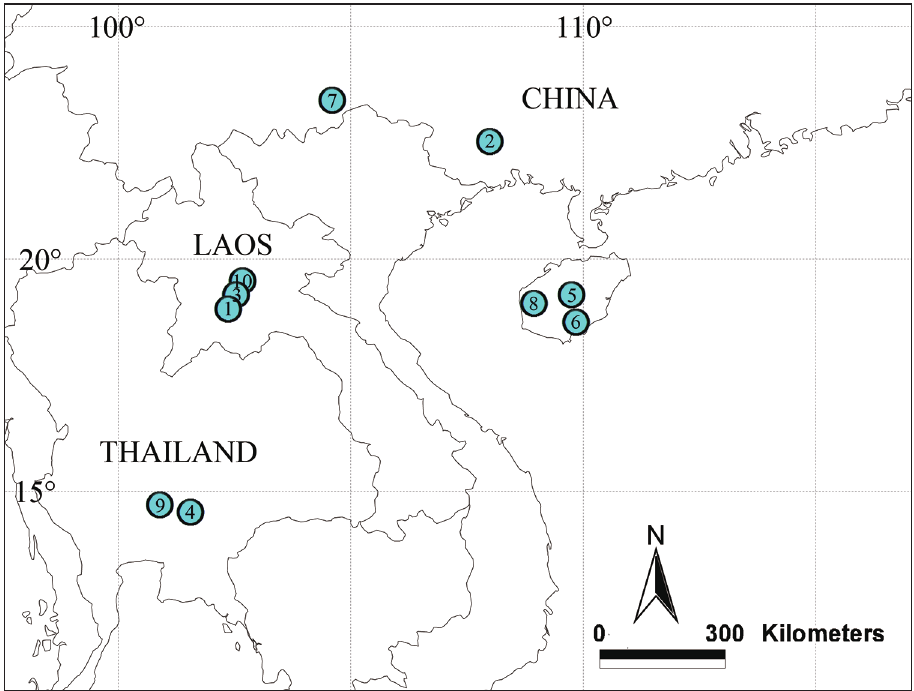
Figure 22. Distribution of ten new Sinoderces in China, Laos and Thailand 1 Sinoderces khanensis sp.